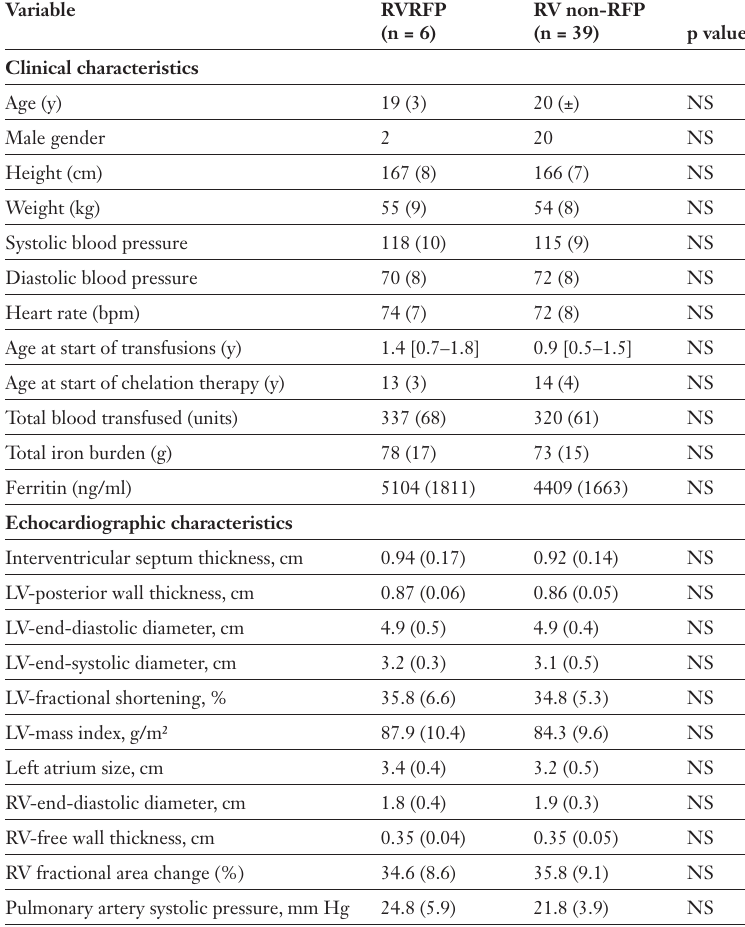
Comparison of baseline clinical and echocardiographic data in thalassaemia major patients with right ventricular restrictive filling pattern and right ventricular non-restrictive filling